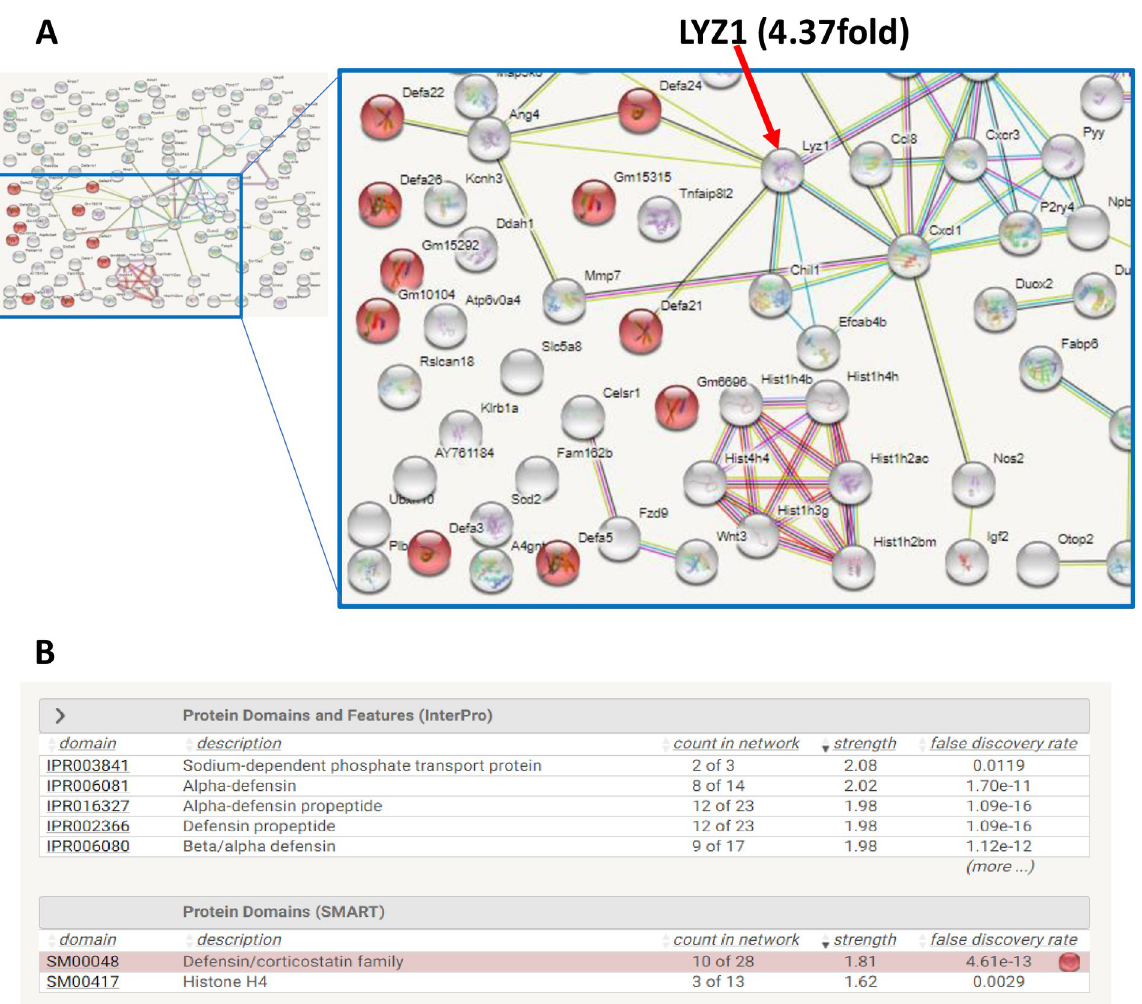
Fig 2. STRING network and enrichment analysis identifying LYZ1 and defensins as candidates altered by NCT. A: Diagram from STRING shows protein-protein interaction networks for 122 genes upregulated by > 2.9 fold by NCT in HFD+NCT treated mouse intestine (GSE178435). Each node represents upregulated candidates and colored lines between the nodes indicate different types of evidence for protein-protein interactions as shown in the legend. Red nodes indicate protein domain, Defensin family (10 of 122 genes) and the red arrow indicates Lysozme1 (LYZ1) with fold change. B: STRING enrichment analysis for the top 122 upregulated gene candidates in NCT-treated mouse intestine, identifying defensins as enriched protein domains.